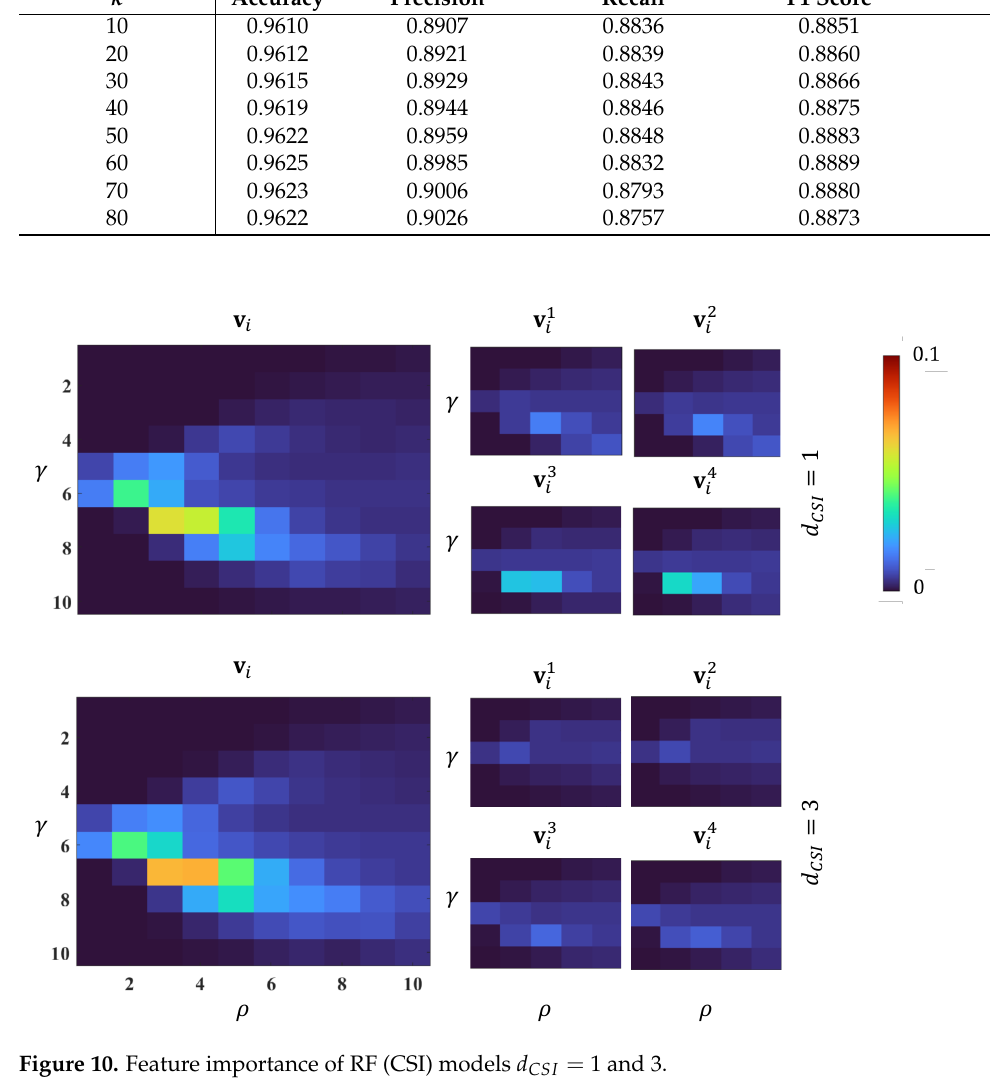
Figure 10. Feature importance of RF (CSI) models d CSI = 1 and 3.